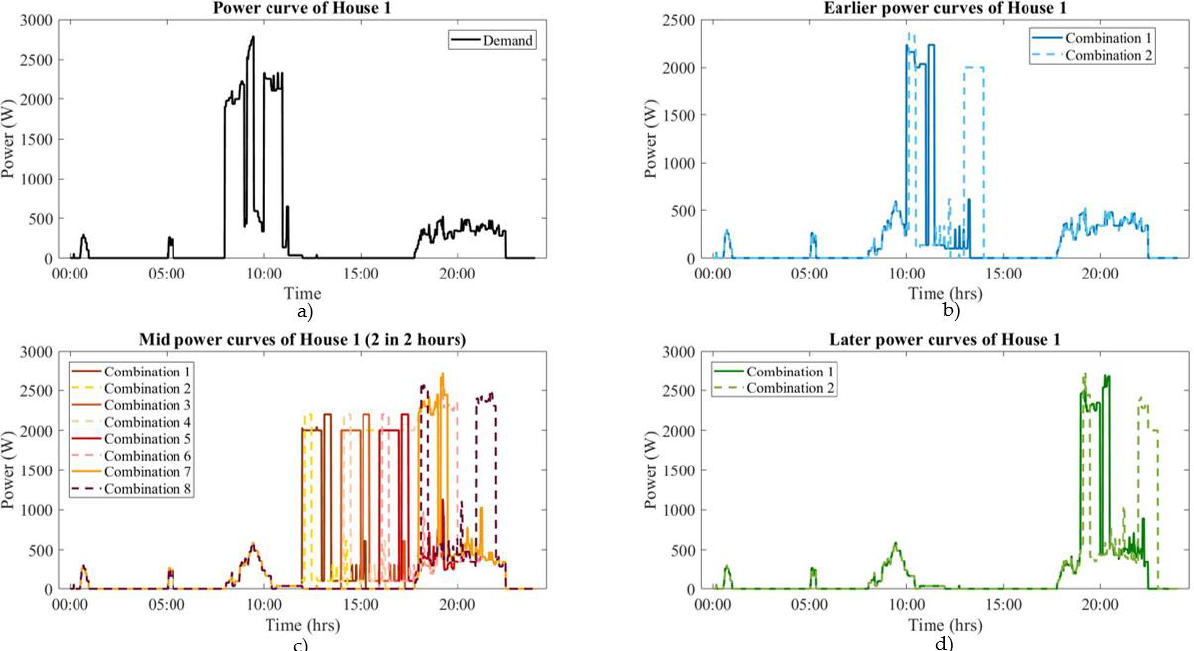
Figure 9. Load profile of house 1: ( a ) Normal load; ( b ) Earlier start combinations; ( c ) Mid start combinations; ( d ) Later start combinations.